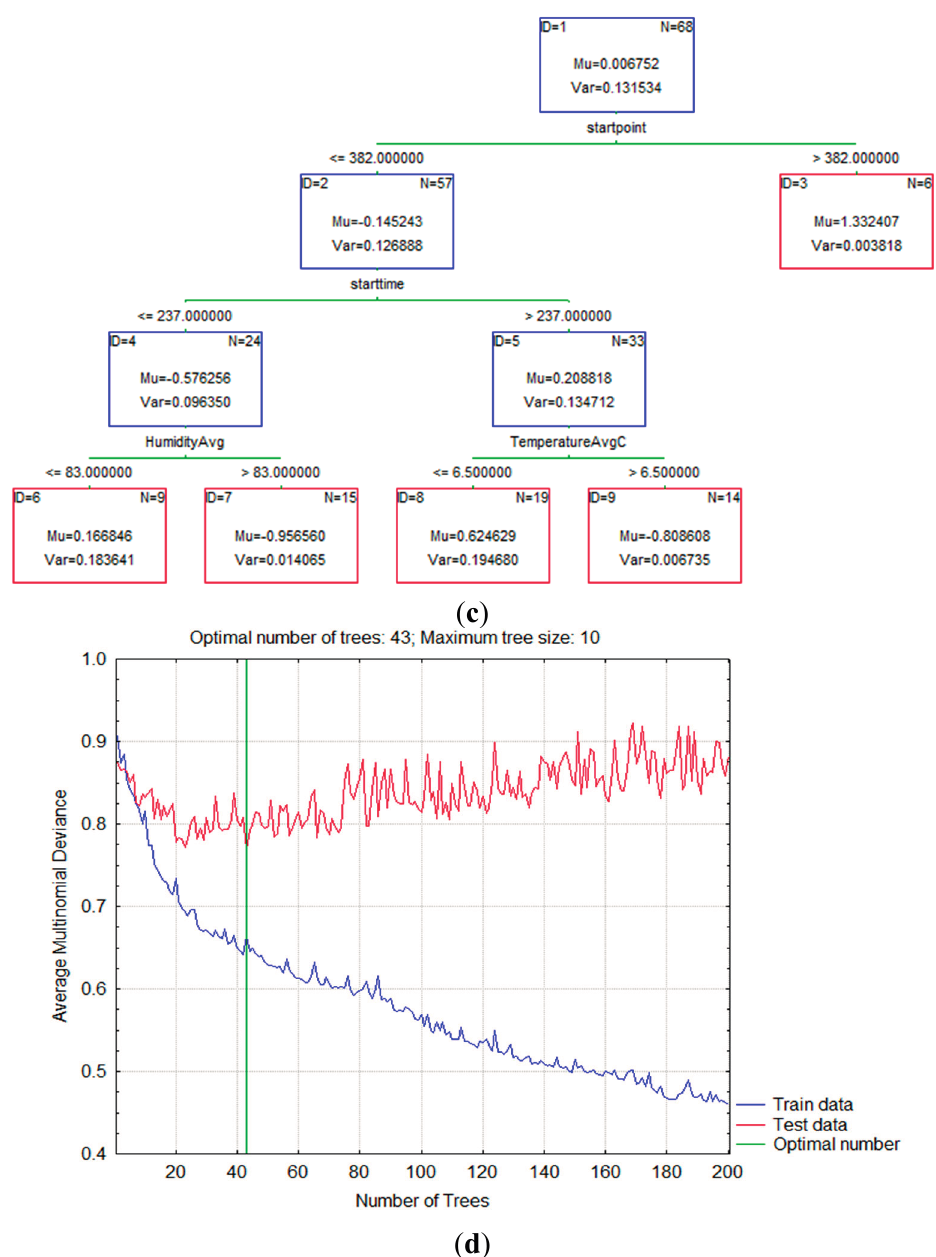
Figure 2. ( a ) An example of the simple tree for the transportation mode bike; ( b ) An example of the simple tree for the transportation mode walk; ( c ) An example of the simple tree for the transportation mode car; ( d ) Average multinomial deviance for boosted trees. As more and more trees were added to the model, the average squared error function for the training data (from which the respective trees were estimated) decreased. This clearly showed the improvement of the learning process as the model was able to learn from the errors of previous trees and make more accurate predictions regarding the transportation mode that the individual will use. Based on the average squared error value we were able to estimate the optimal number of trees as it clearly marked the point where the smallest error for the testing data occurred. Table 3 shows values of standard errors for both test and train data